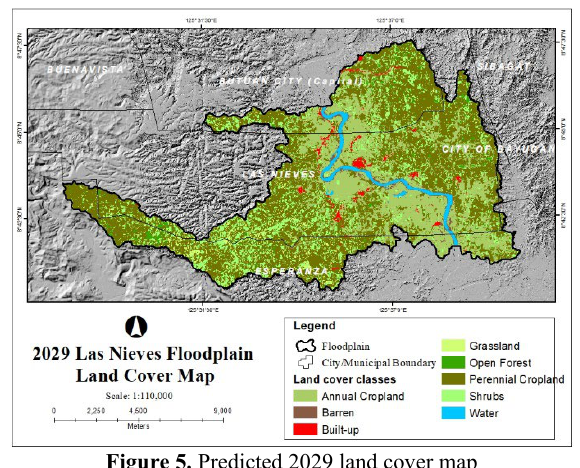
Figure 5. Predicted 2029 land cover